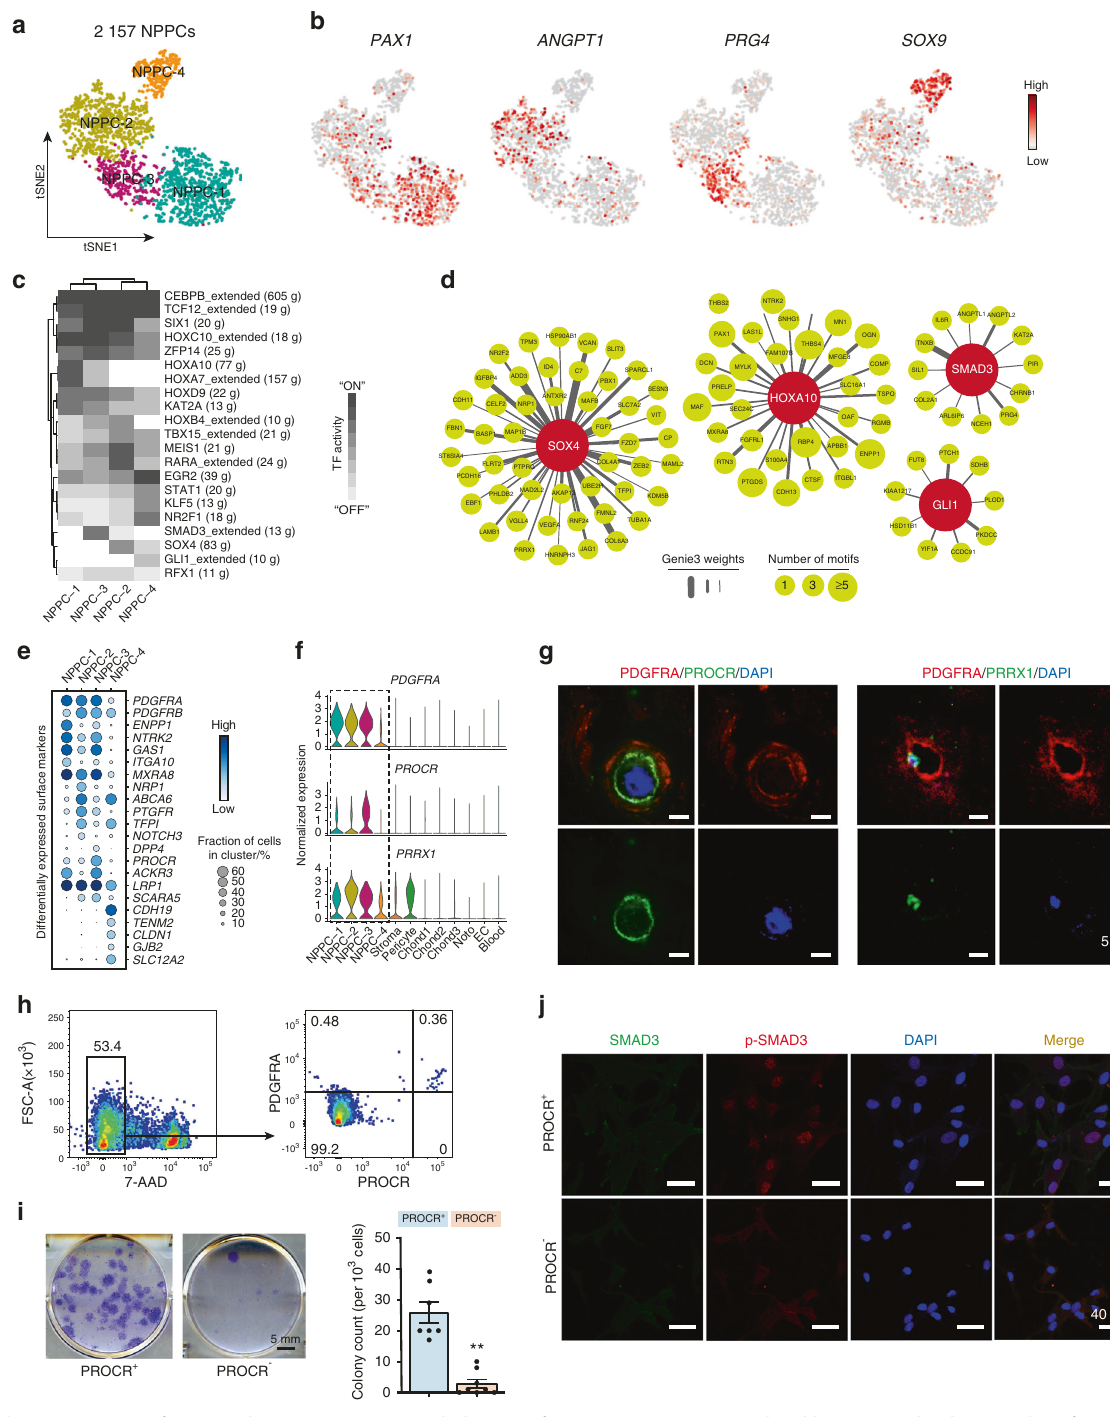
Fig. 3 Characterization of NPPC in human IVD. a Four subclusters of 2 157 NPPCs were visualized by a tSNE plot. b tSNE plot of signature gene expression in NPPCs. c Heatmap revealing binary regulon activities analyzed with SCENIC in each subcluster of NPPCs. “ ON ” indicates active regulons; “ OFF ” indicates inactive regulons. SCENIC Single-Cell Regulatory Network Inference and Clustering. d The HOXA10, SOX4, SMAD3, and GLI1 regulon networks in NPPC subclusters. The TFs are in dark red, and the corresponding target genes are in light green. The line thickness indicates the level of GENIE3 weights. The dot size indicates the number of enriched TF motifs. TFs transcription factors, GENIE3 GEne Network Inference with Ensemble of trees. e Dot plot showing differentially expressed genes encoding surface markers in each subcluster of NPPCs. f Violin plots showing the expression levels of the signature genes of NPPC-3 in the IVD. g Immuno fl uorescence staining showing the coexpression of PDGFRA, PROCR, and PRRX1 in human IVD cells in situ ( n = 3). Scale bar, 5 μ m. h Flow cytometry gating strategies for sorting PDGFRA + PROCR + in the human IVD. i Representative crystal violet staining of CFU-F colonies generated by sorted primary PROCR + cells of the human IVD (left, n = 3). Scale bar, 5 mm. Quanti fi cation of the number of CFU-F colonies (right). The statistical signi fi cance of differences was determined using one-way ANOVA with multiple comparison tests (LSD). ** P < 0.000 1. Error bars indicate the SEM. CFU-F colony-forming unit- fi broblast, ANOVA Analysis of Variance, LSD least signi fi cant difference, SEM Standard Error of the Mean. j Immuno fl uorescence staining of SMAD3 and p-SMAD3 in the PROCR + and PROCR − cells of the human IVD ( n = 3). Scale bar, 40 μ